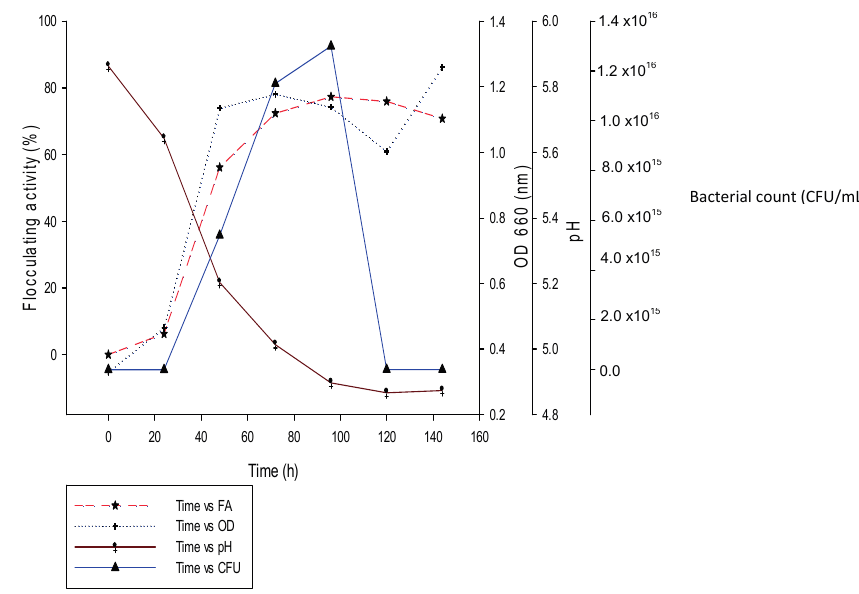
Figure 6. Time course of REG-6 production by Bacillus toyonensis strain AEMREG6.